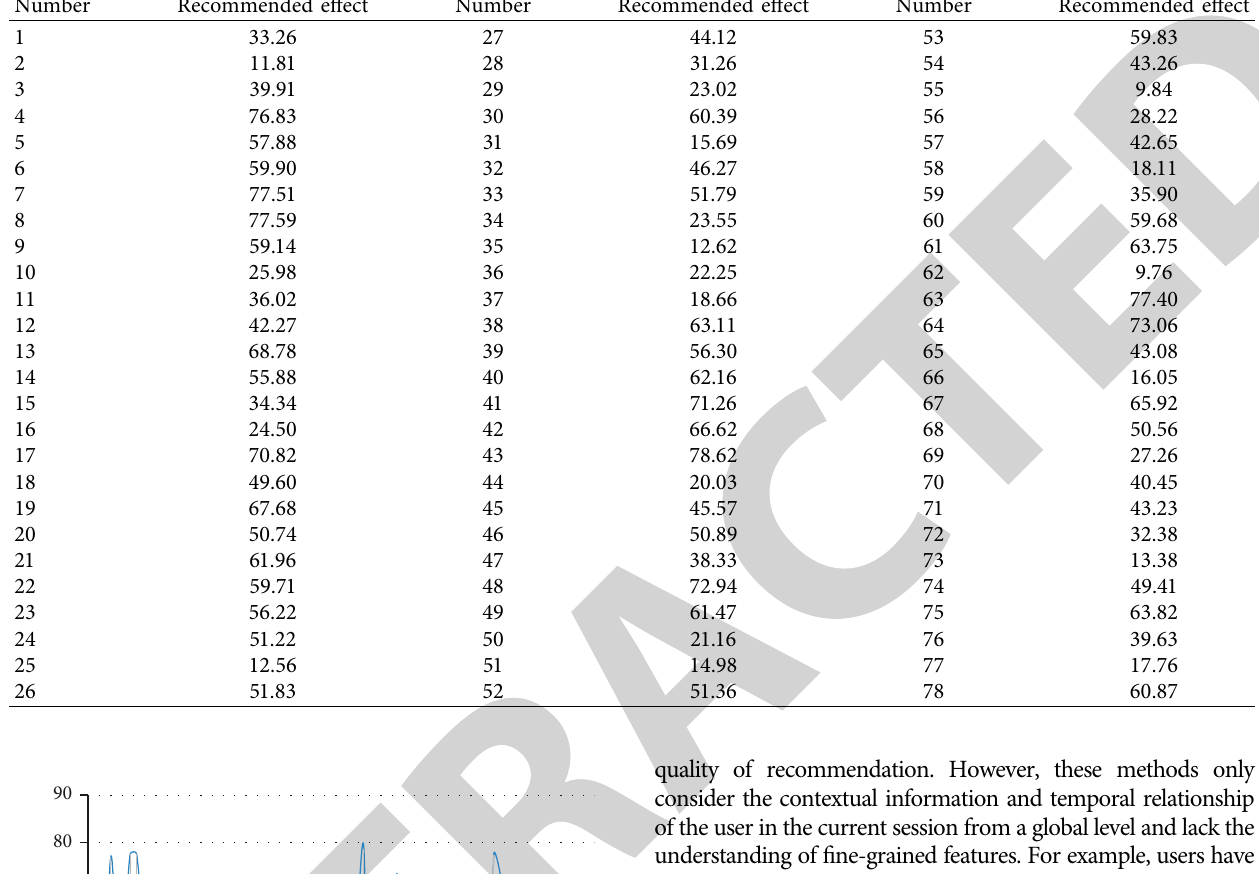
Table 1: Effect verification of hybrid music recommendation system with the fusion of music genes.